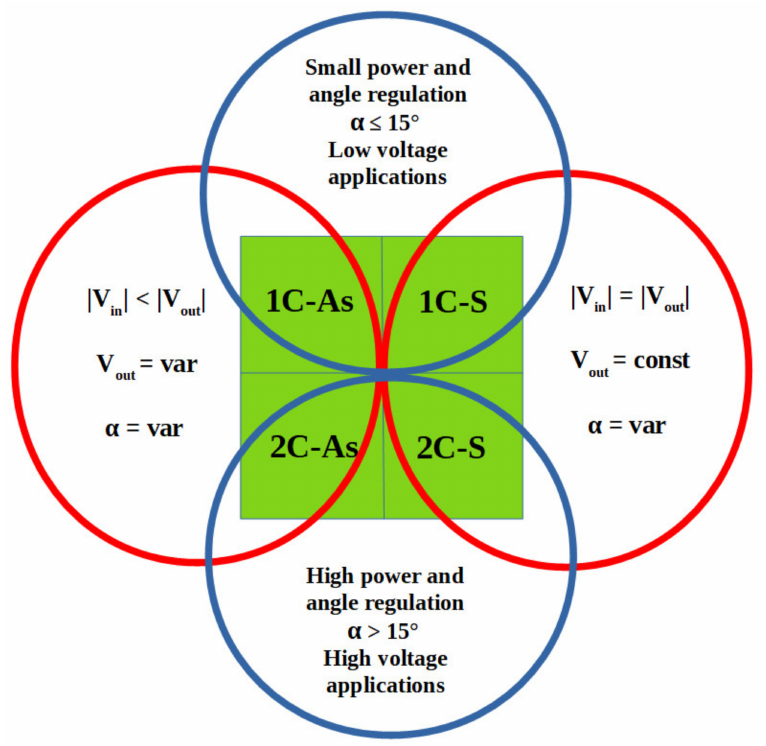
Figure 5. The comparison of select features between the different PST types. 1C—single-core, 2C—dual-core, As—asymmetrical, S—symmetrical [22,23].